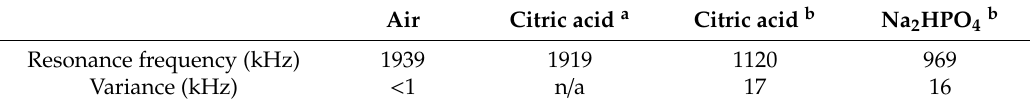
Table 3. Frequency shift of resonator under different conditions.